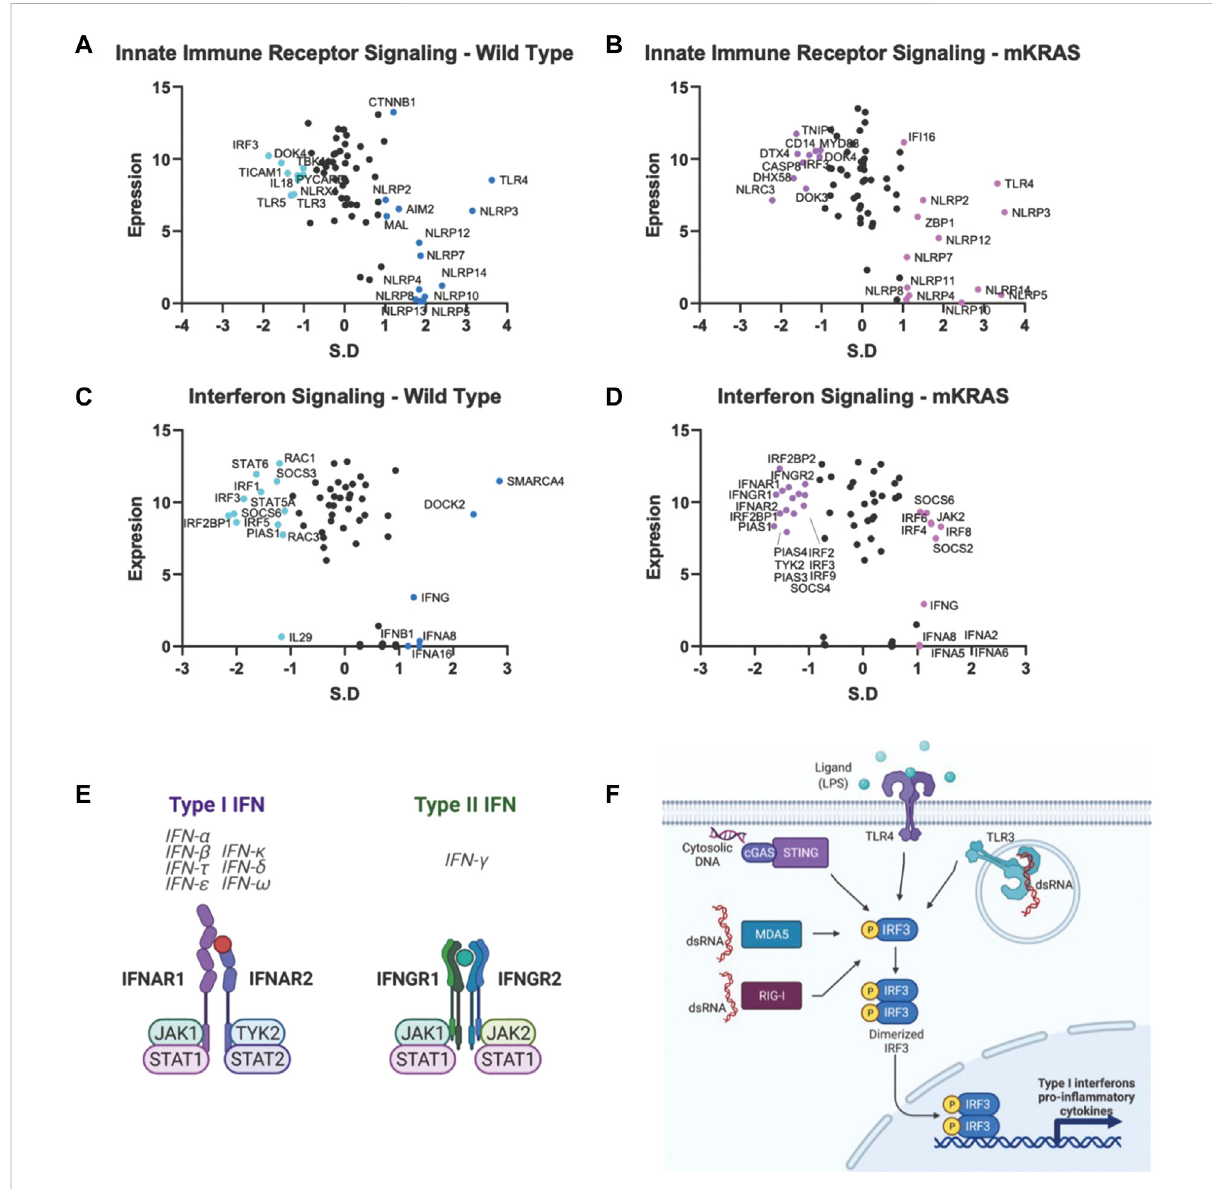
FIGURE 5 Gene conservation in pro-in fl ammatory genes. Gene conservation score, measured as the standard residual from the regression line (SR) graphed against genes expression levels (Log2). Innate immune signaling genes in WT (A) and mKRAS (B) . Interferon signaling genes in WT (C) and mKRAS (D) . Conserved genes (SR ≤ -1.0) and over-mutated genes (SR ≥ 1.0) are colored and labelled with text. Type-I and Type-II interferon receptors are conserved in mKRAS (E) . Interferon regulatory factor 3 (IRF3) is a central component in multiple pattern recognition receptor pathways (F) . Standardized residual (SR). Created with